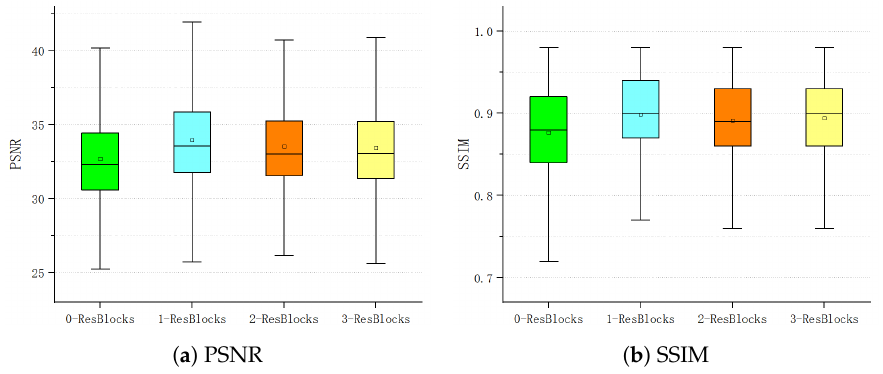
Figure 16. The distribution of PSNR and SSIM of Ref-MFFDN with different layers of ResBlocks added in MFE on the testing set. The box plot displays the maximum, upper quartile, median, lower quartile, and minimum of results from top to bottom. The rectangle inside the box represents the average metrics of the